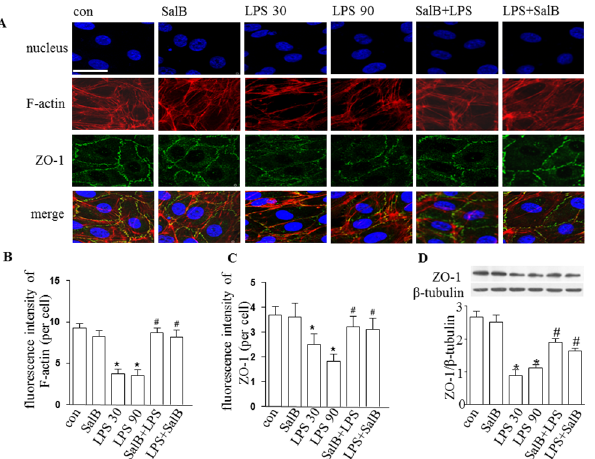
Fig 4. Effect of SalB on the distribution and expression of ZO-1 in HUVECs. A: Representative images of confocal microscopy showing of distribution of ZO-1 (green) and F-actin (red) in HUVECs in different groups. Hoechst 33342 was applied to stain nuclei (blue). Bar = 25 μ m. B: Quantitative assessment of F-actin in HUVECs. C : Quantitative assessment of ZO-1 in HUVECs. D : Western blot showing protein level of ZO-1 the ratio of ZO-1/ β -tubulin in HUVECs in different groups. Data were expressed as mean ± SE of 6 independent experiments. * p < 0.05 vs. control group; # p < 0.05 vs. LPS 30 and LPS 90 groups. One-way analysis of variance (ANOVA) with Turkey post hoc test was